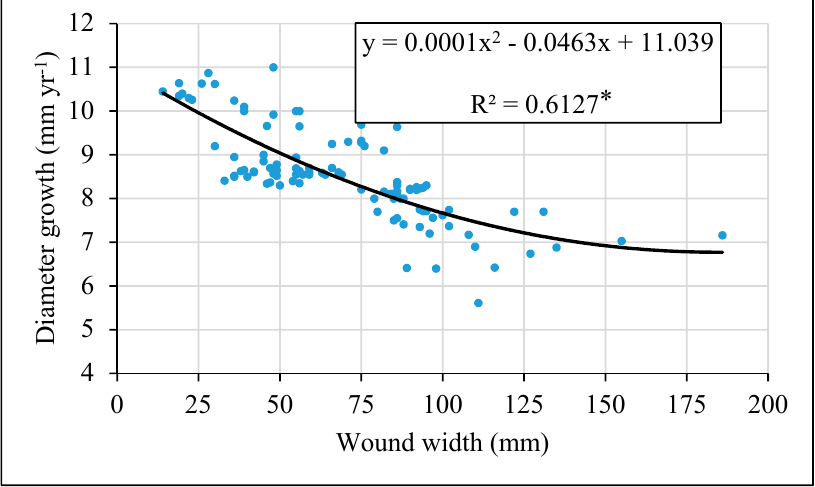
Figure 9. Wounded diameter growth in relation to wound width.